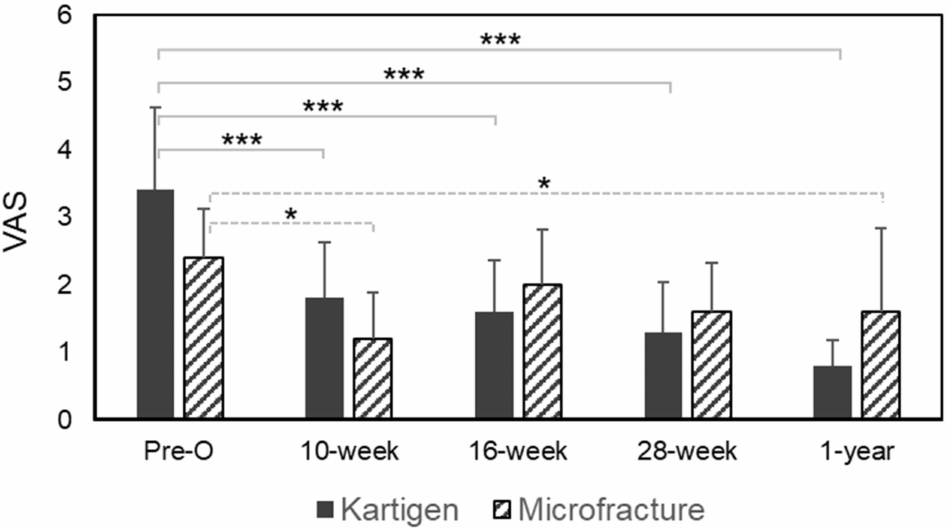
Figure 2. VAS assessment. The pain relief was effective and significant in the Kartigen ® -treated group, as VAS scores decreased since the 10th week after operation, but the VAS scores flatulated in the control group. The error bars stand for standard deviations. Asterisks represent the statistical significance: * p < 0.05, *** p <